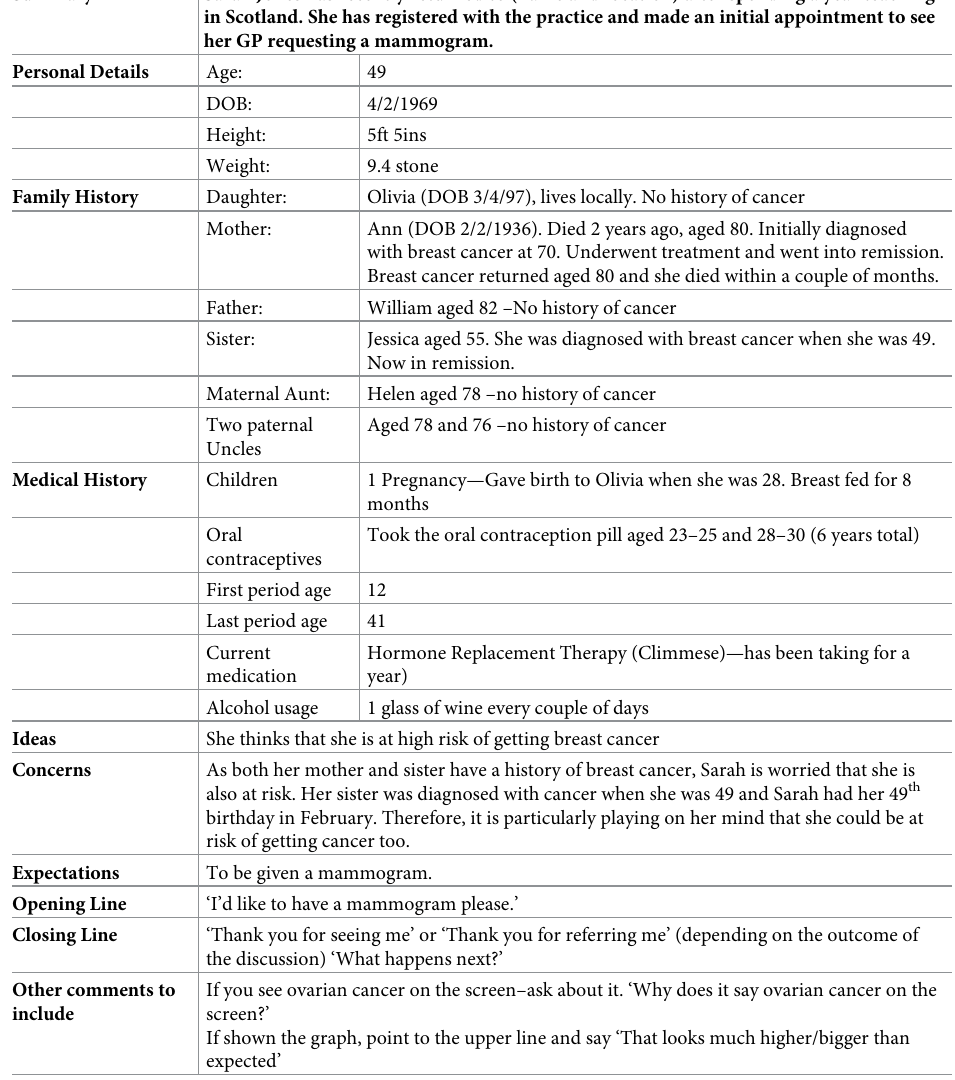
Table 1. Example role player scenario and script used in England.